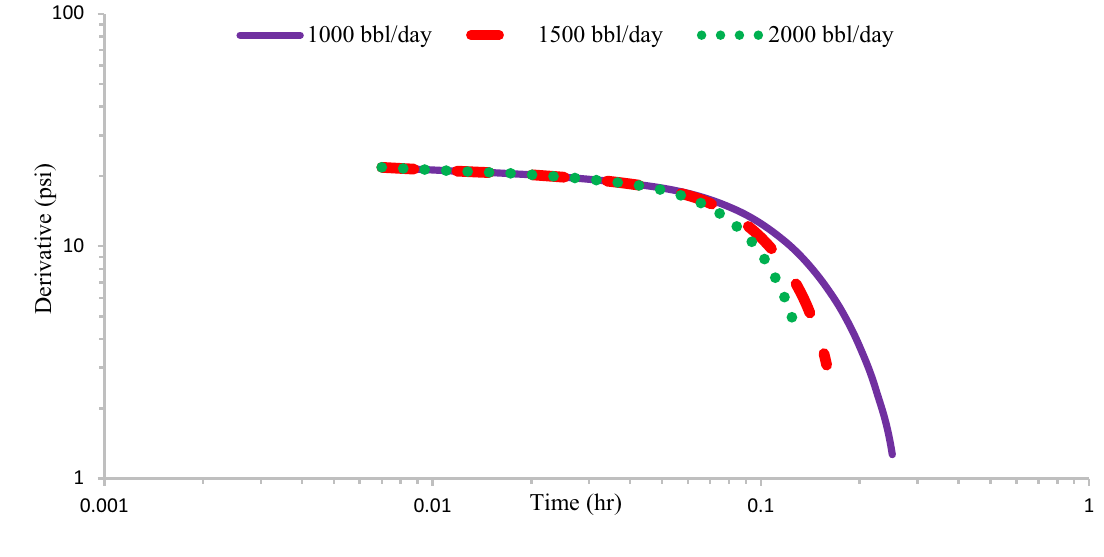
Fig. 15 Sensitivity analysis of scenario No. 5 on the rate of the adjacent well in naturally fractured reservoir